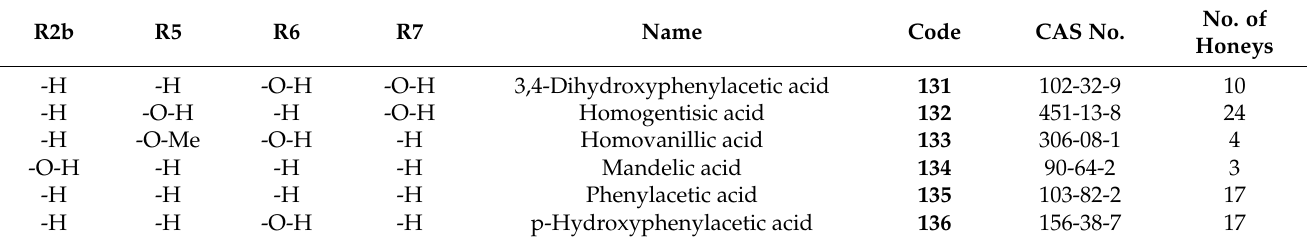
Figure 17. Basic structure of hydroxyphenylacetic acid and derivatives (HPAAD) (see 131 – 136 in Table 11). Table 11. Hydroxyphenylacetic acid and derivatives (HPAAD) reported in monofloral honeys (see Figure 17 for general structure).